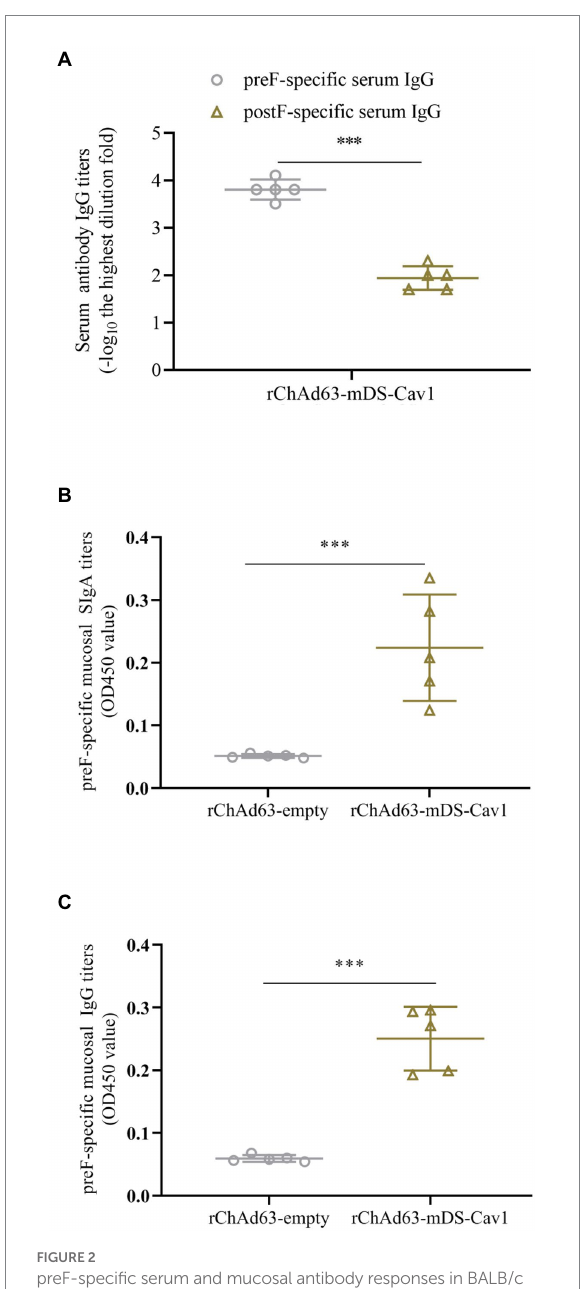
FIGURE 2 preF-specific serum and mucosal antibody responses in BALB/c mice following immunizations. BALB/c mice ( n = 5) were immunized intranasally with recombinant adenovirus (1 × 10 10 VP/ mouse). On the 21 st day after immunization, the preF-specific IgG and IgA were detected by ELISA. Serum anti-preF IgG and anti- postF IgG (A) , mucosal anti-preF SIgA (B) and IgG (C) responses induced by rChAd63-mDS-Cav1. Data were shown as mean ± SD, *** p <